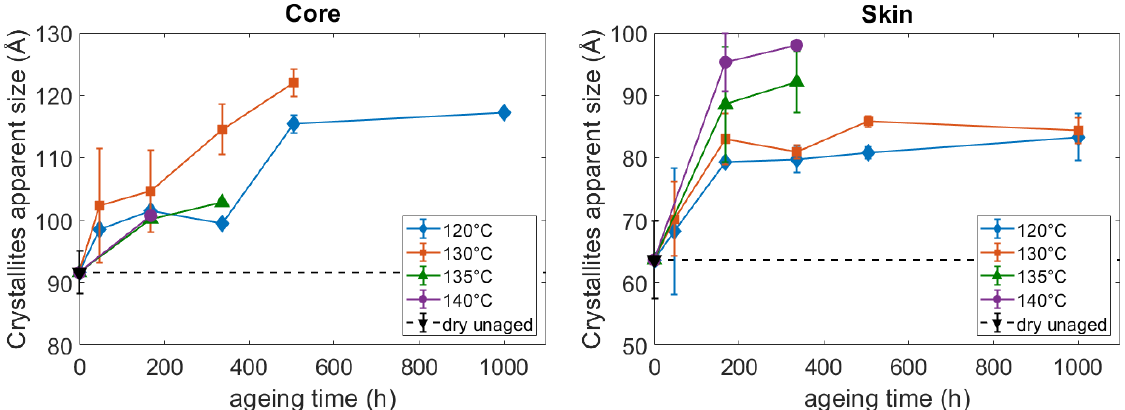
Figure 10. Influence of the ageing conditions on the CAS at the core and at the surface of the PA66 plaques.